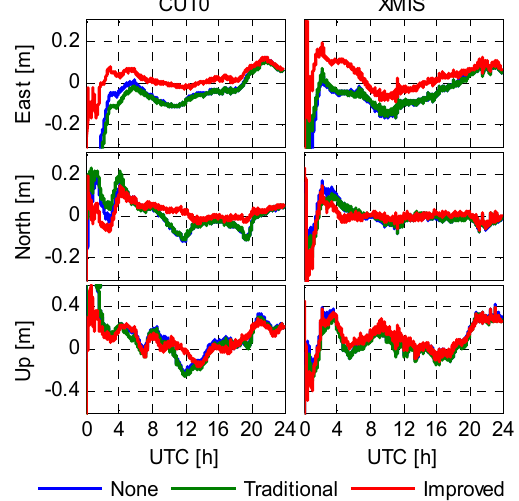
Figure 10. Epoch-wise PPP solutions of CUT0 and XMIS (DoY 130/2015).